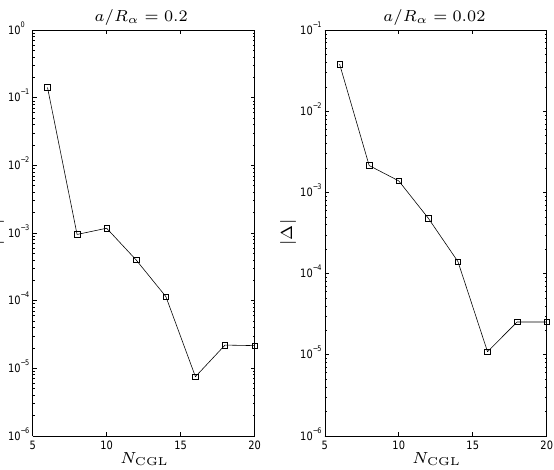
Figure 4: Convergence analysis. Fundamental frequency λ = ω ( a 2 / h ) √︀ ρ / E 2 of a moderately thick ( a / h = 10 ) square fully clamped [0/90/0] spherical panel with a / R α = 0.2 and a / R α = 0.02 . Values computed using ED2 theory.